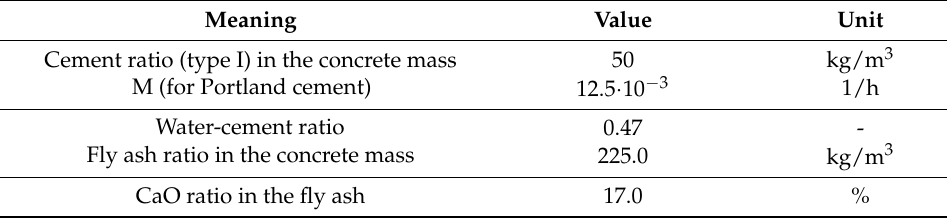
Table 5. Concrete hydration analysis parameters.